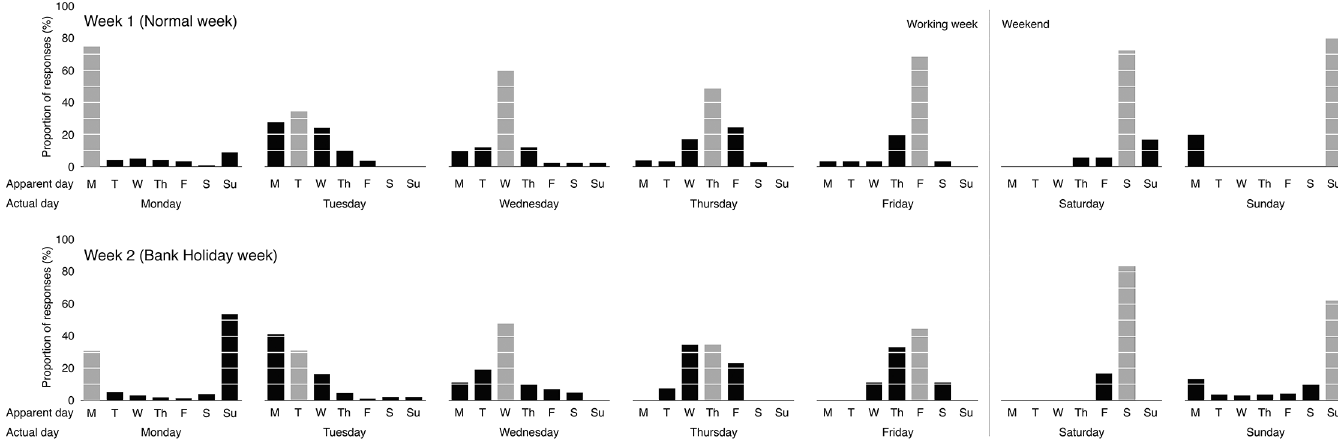
Fig 1. Proportions (%) of apparent day responses for each actual day, shown separately for Normal Week (top row) and Bank Holiday Week (bottom row). Grey bars denote matches between apparent day and actual day. Black bars denote